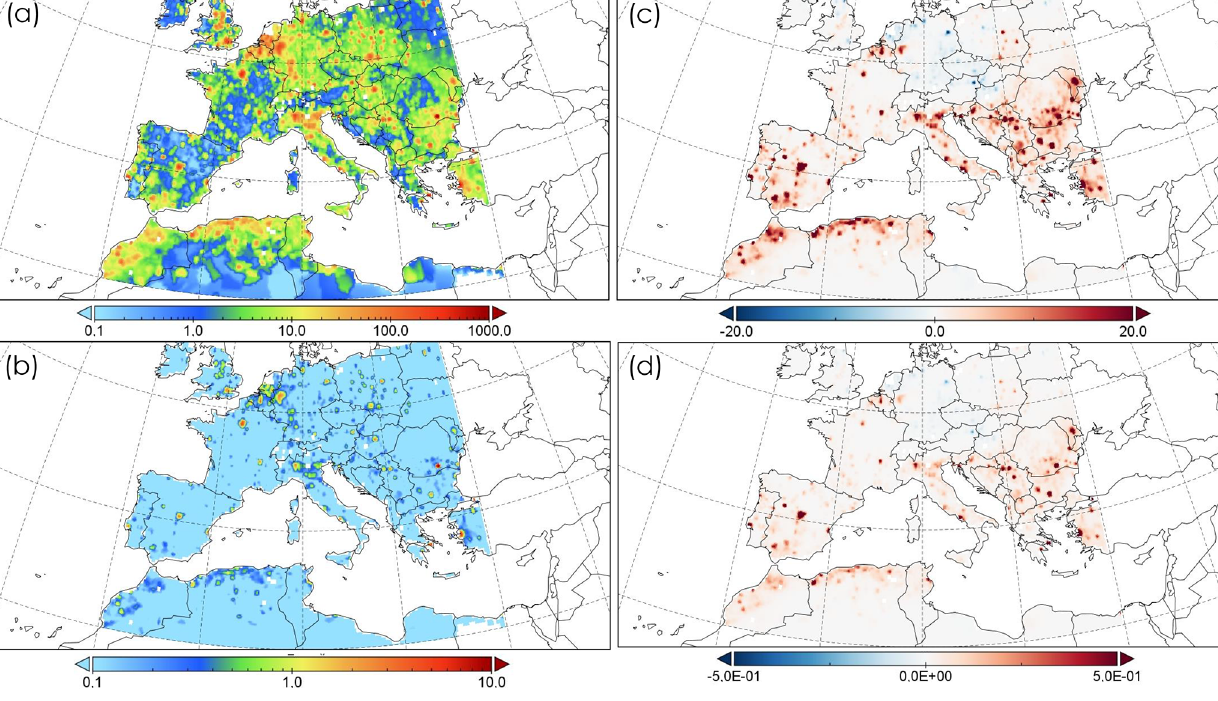
Figure 4. (a) Present cases of congestive heart failure (CHF) and (b) associated costs, in millions of euros. (c) Changes projected in CHF cases and (d) changes in costs (millions of euros) under the RCP8.5 scenario